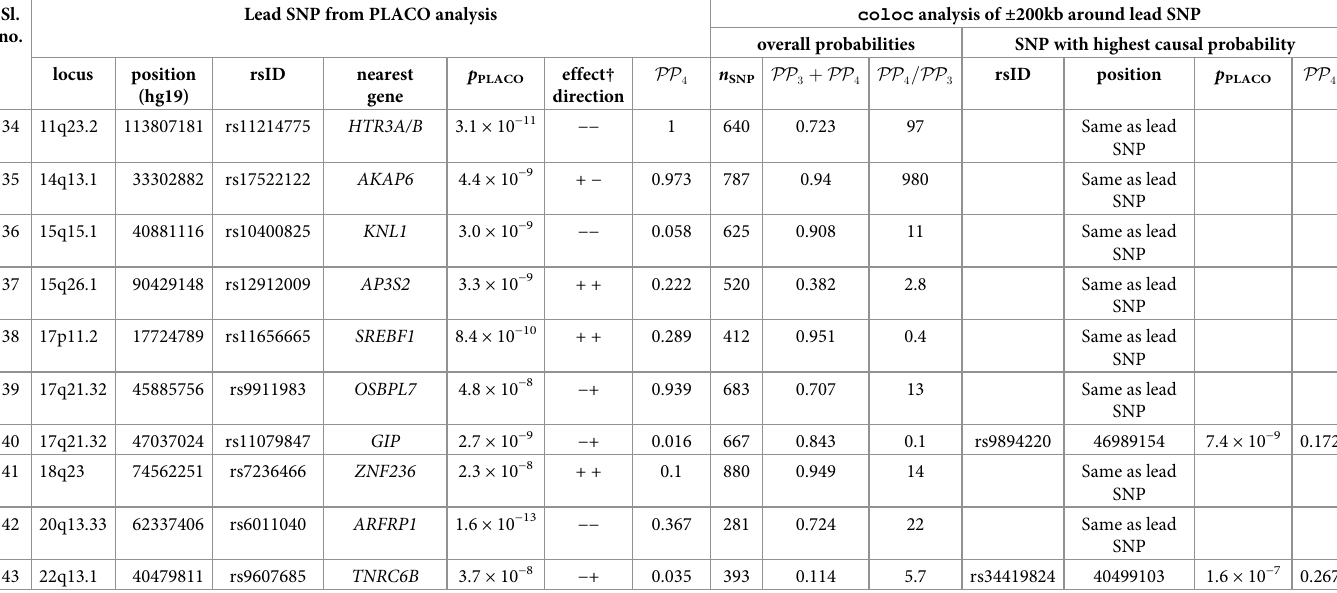
Table 2. The potentially novel loci detected by PLACO and with convincing evidence ( PP from colocalization analysis. Locus